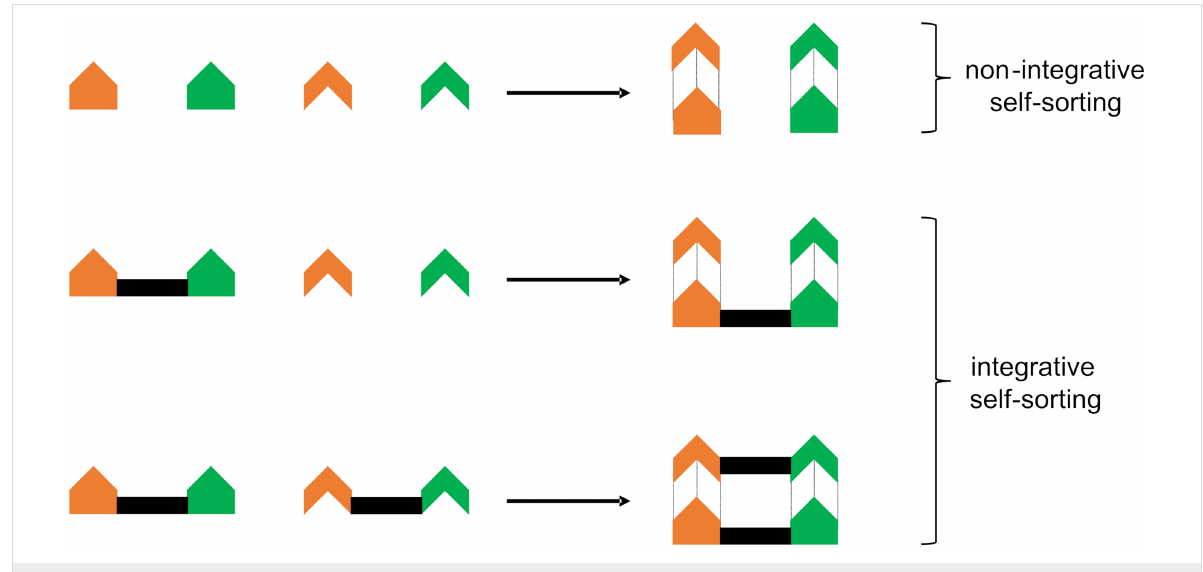
Figure 2: Illustration of an integrative vs a non-integrative